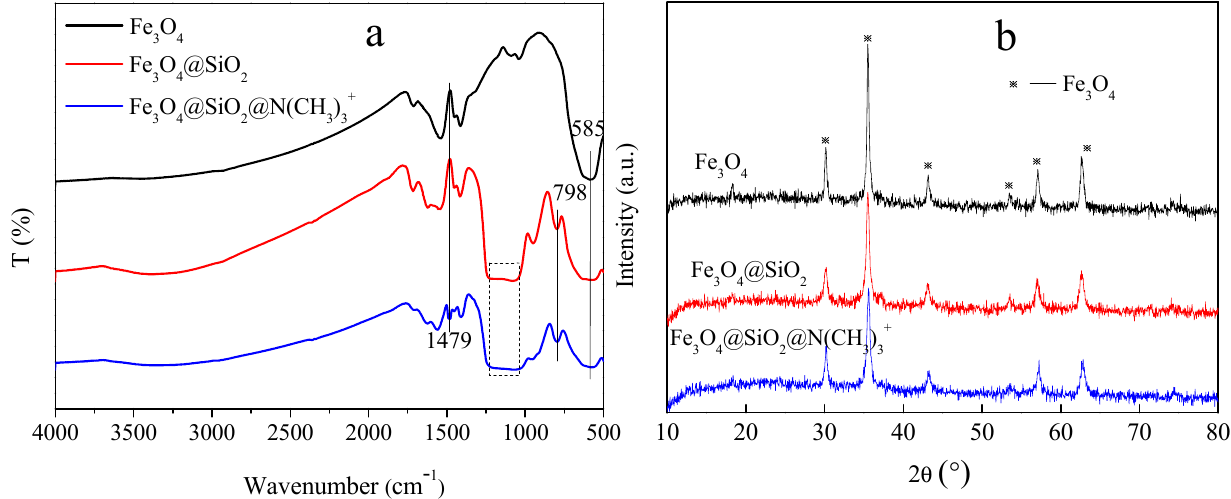
Figure 2. ( a ) FT-IR spectra and ( b ) XRD pattern of Fe 3 O 4 , Fe 3 O 4 @SiO 2 , Fe 3 O 4 @SiO 2 @N(CH 3 ) 3+ . The full-survey spectrum of the Fe 3 O 4 @SiO 2 and Fe 3 O 4 @SiO 2 @N(CH 3 ) 3+ are presented in Figure 3, and there are significant peaks at 532.05 eV, 152.19 eV, and 102.54 eV corresponding to O 1 s, Si 2 s, and Si 2 p, respectively [27,28]. Moreover, the high-resolution spectra of Si 2 p and N 1 s are shown in Figure 2b,c. In Si 2 p spectrum, the strength of Si